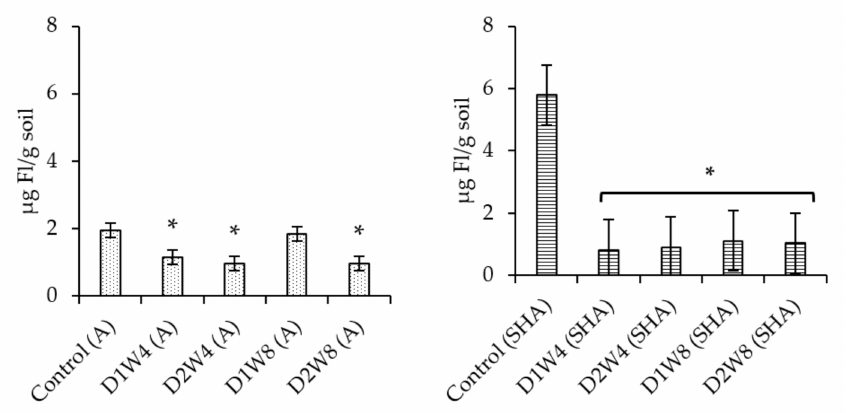
Figure 2. FDA enzyme activity of Arenosol and slightly humous Arenosol. The codes means the following treatments: Control (A): Control Arenosol. D1W4 (A): Dose 1 week 4 (Arenosol). D2W4 (A): Dose 2 week 4 (Arenosol). D1W8 (A): Dose 1 week 8 (Arenosol). D2W8 (A): Dose 2 week 8 (Arenosol). Control (SHA): Control slightly humous Arenosol. D1W4 (SHA): Dose 1 week 4 (slightly humous Arenosol). D2W4 (SHA): Dose 2 week 4 (slightly humous Arenosol). D1W8 (SHA):